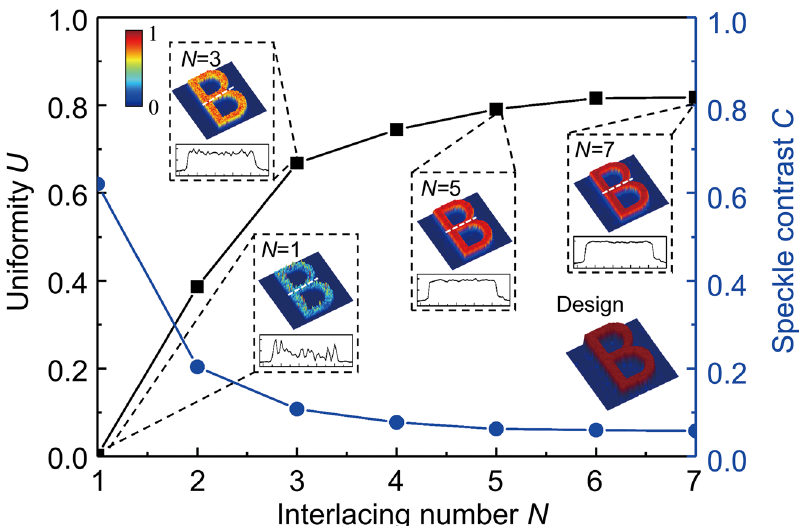
white dashed lines.